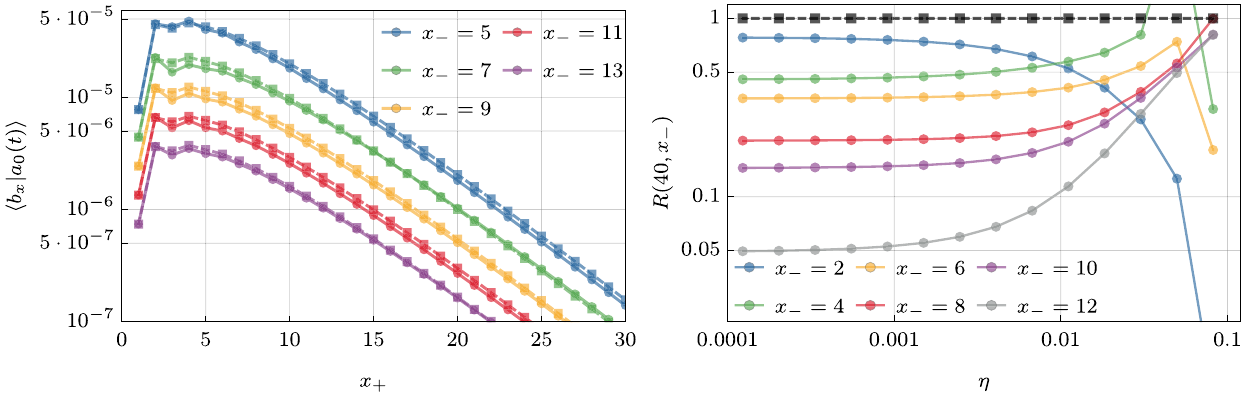
FIG. 8. Left: correlation functions of operators a ¼ b ¼ σ x at integer sites versus x results, and dashed lines are the predictions of Eq. (43). Right: relative errors versus η at different x − . A gate that does not fulfill Eq. (88) is drawn in black. The results are for symmetric generic gates, as specified in Table II, with maximal density of defects δ ¼ 1 .